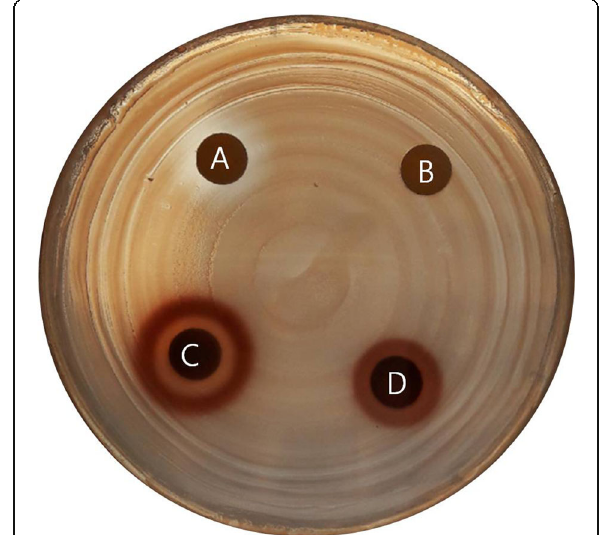
Fig. 1 Antibacterial activity of ES against P. acnes ( a ; tetracycline 50 μ g/ml, b ; DMSO, c ; ES 200 mg/ml, d ; ES 100